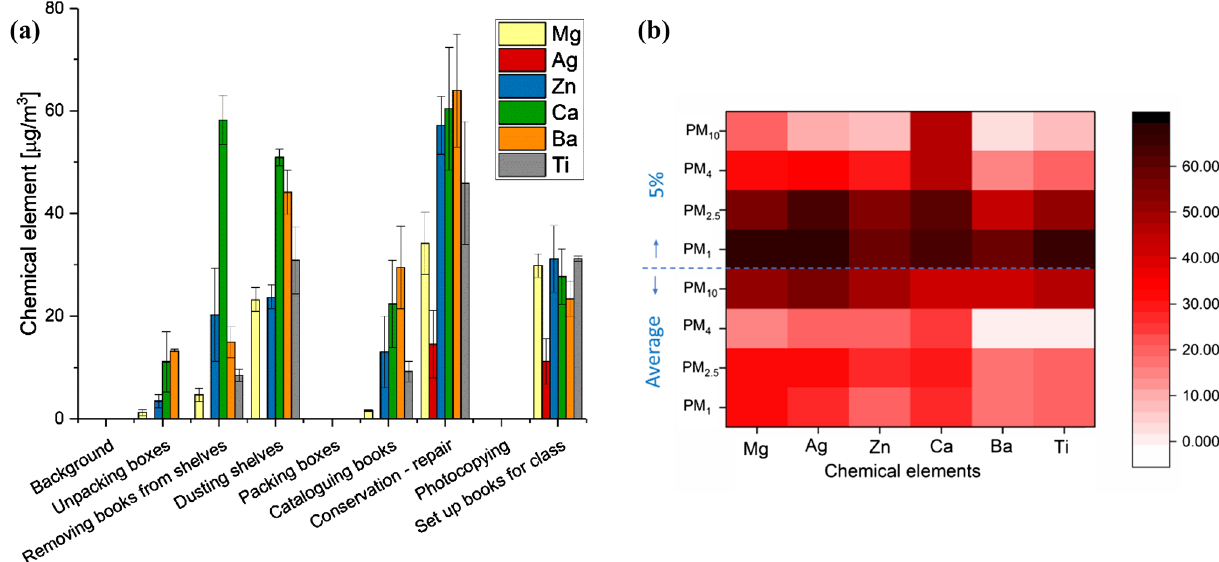
(PM , PM , PM , and PM ) ( b ). The exposure limits of metal nano- 1 2.5 4 10 particles are not reported since much above the shown